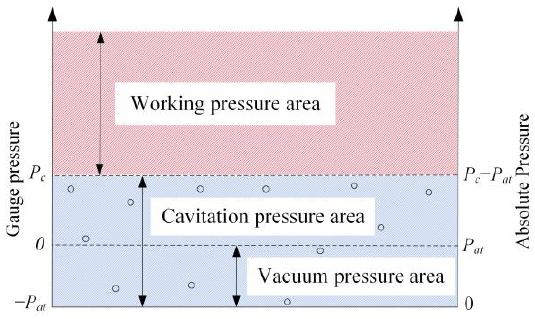
Figure 8. The hydraulic system pressure area division.